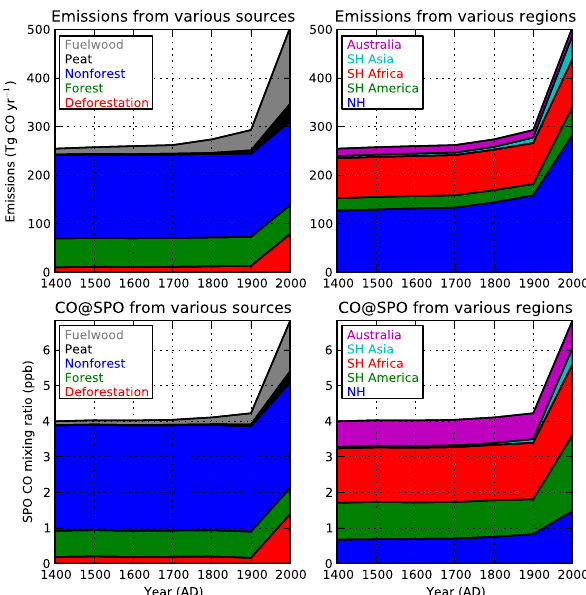
Fig. 10. Reconstructed emissions and corresponding SPO CO mix- ing ratios when all sources except forest and “nonforest” (savanna, woodland, agricultural waste burning) were scaled with rural popu- lation density. NH is Northern Hemisphere, SH is Southern Hemi- sphere.